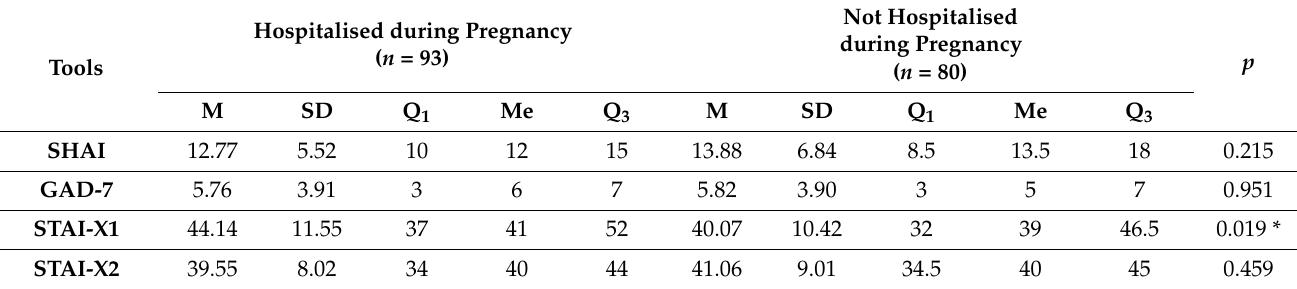
Table 5. The impact of hospital stays during pregnancy on the rating of anxiety.